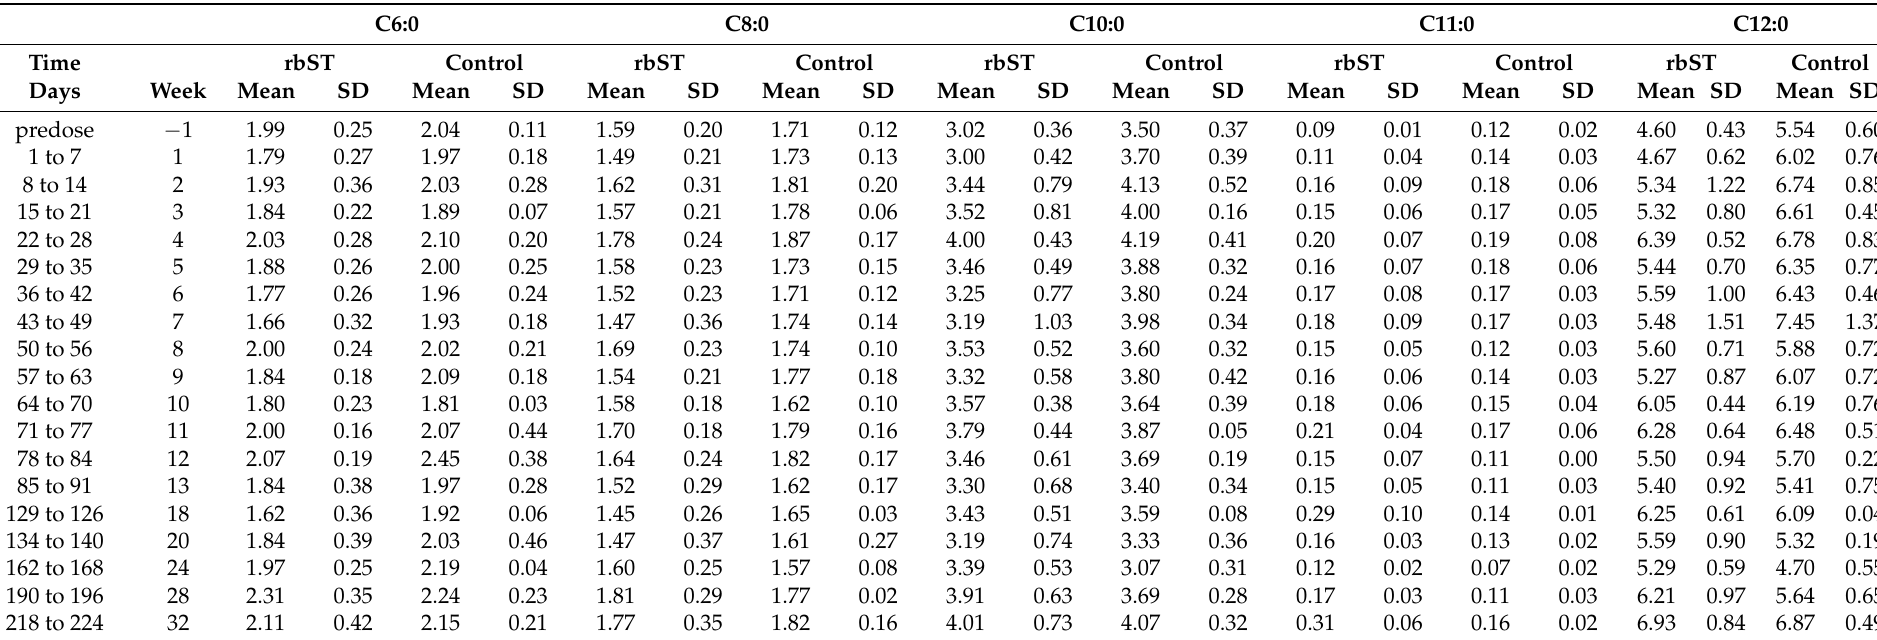
Table 1. Short-chain and medium-chain saturated fatty acids in milk (% w / w of total fatty acids) obtained from cows treated with recombinant bovine somatotropin (rbST) ( n = 6) and from control animals ( n = 3) at different time points selected over the course of 37 weeks (8 injections of Lactotropina manufactured by Elanco, Eli Lilly, Mexico). C6:0 C8:0